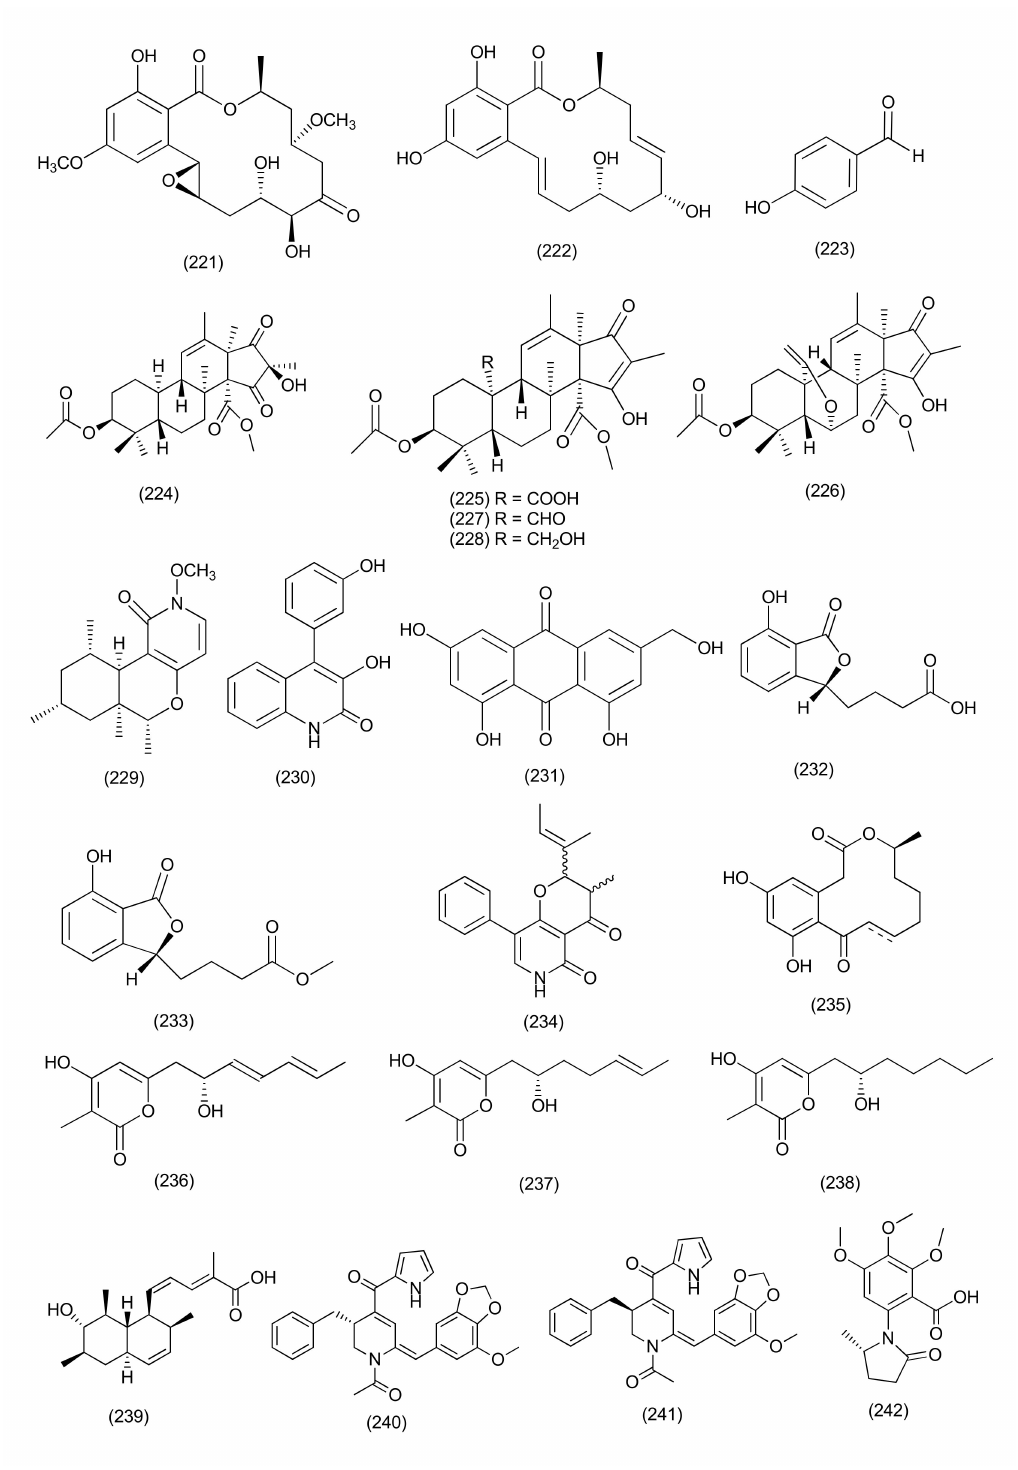
Figure 13. Structures of metabolites 221 – 242 isolated from Anamorphic Ascomycetes. A novel N-methoxy-1-pyridone alkaloid, chromenopyridin A ( 229 ), and the already reported compound viridicatol ( 230 , Figure 13) were purified from Penicillium nothofagi P-6, residing inside the bark of Abies beshanzuensis . Compounds 229 and 230 exhibited antibac- terial activity against S. aureus, with MIC values of 62.5 and 15.6 µ g/mL, respectively